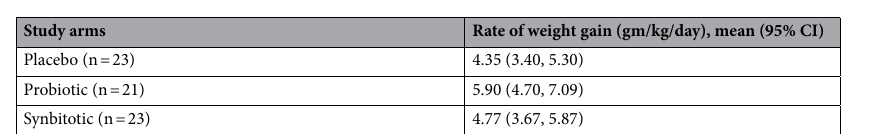
Table 2. Rate of weight gain for SAM infants with three supplementations (from discharge to study completion).